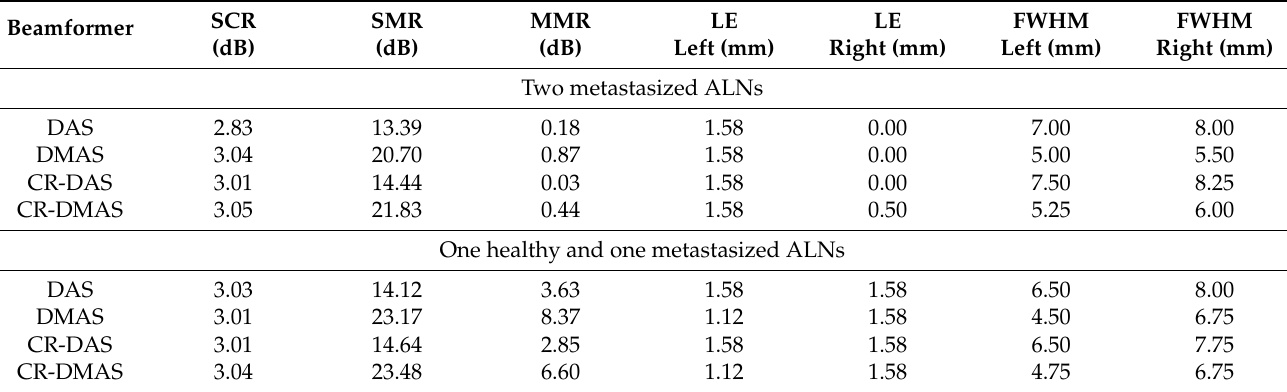
Table 4. Performance metrics of all the beamformers using Bond’s skin artifact removal algorithms for two